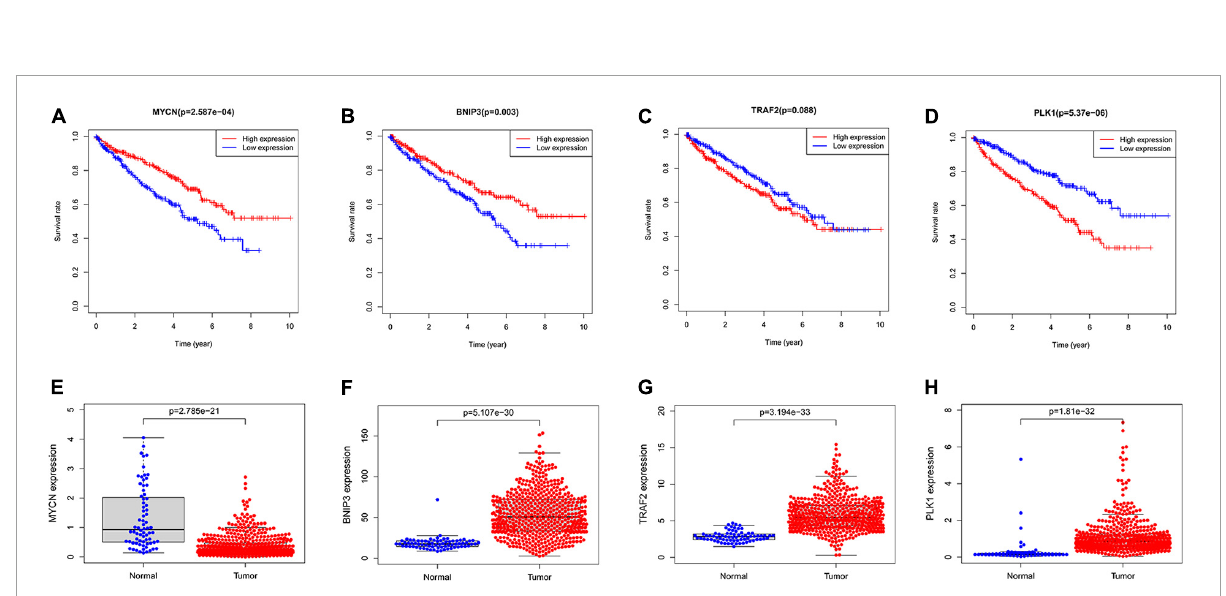
FIGURE9 The predictive value of the four NRGs in ccRCC. (A–D) Kaplan–Meier survival curve analysis verified the prognostic value of the four NRGs in ccRCC; (E–H) verification of the RNA expression of the 4 genes between non-tumor tissues and